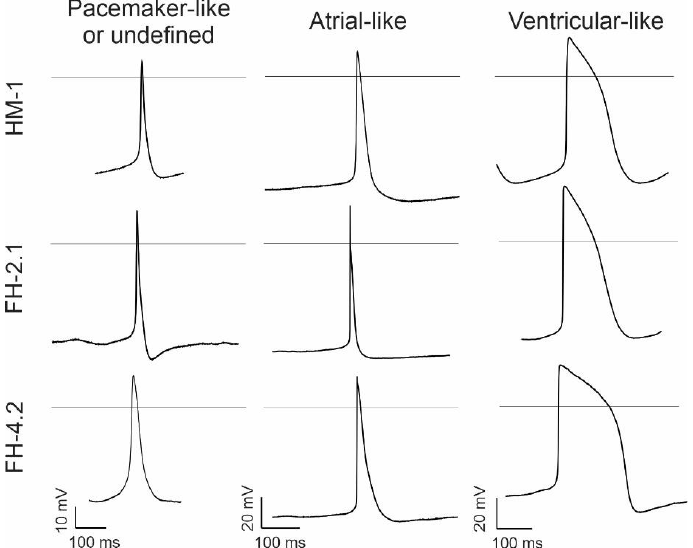
Figure 5. Action potential (AP) analysis. Typical APs of different CM subtypes were recorded from CMs derived from HM-1 ESCs and FH cells (clones FH-2.1 and FH-4.2) at days 16–19 of differentiation. Detailed analysis of different AP parameters in these cells is given in Table 1 and Supplementary Figure S10. Table 1. Action potential (AP) parameters for different subtypes of CMs derived from diploid murine HM-1 ESCs and near-tetraploid fusion-derived hybrid PSCs (clone FH-2.1 and FH-4.2) 1